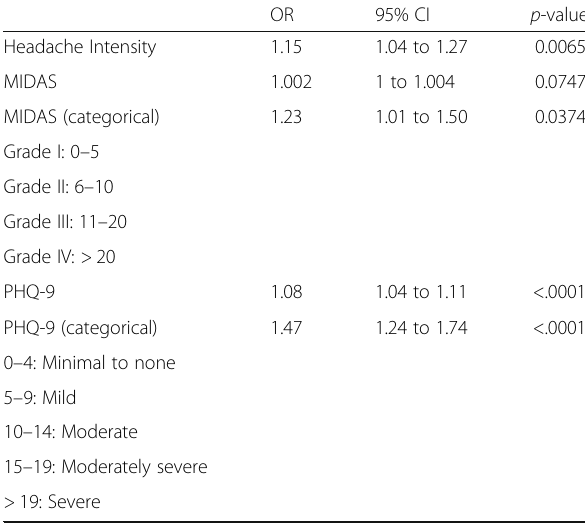
Table 2 Comparing MIDAS, PHQ-9 and average headache intensity between cases and controls